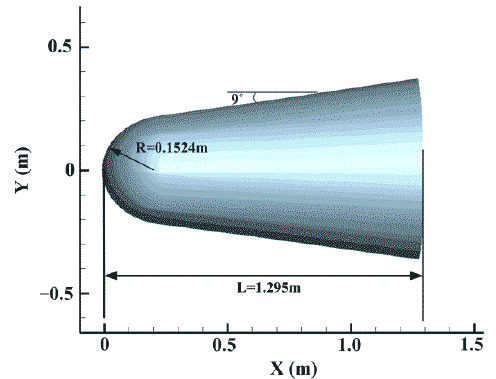
Figure 1. Geometry parameters of the blunt cone.